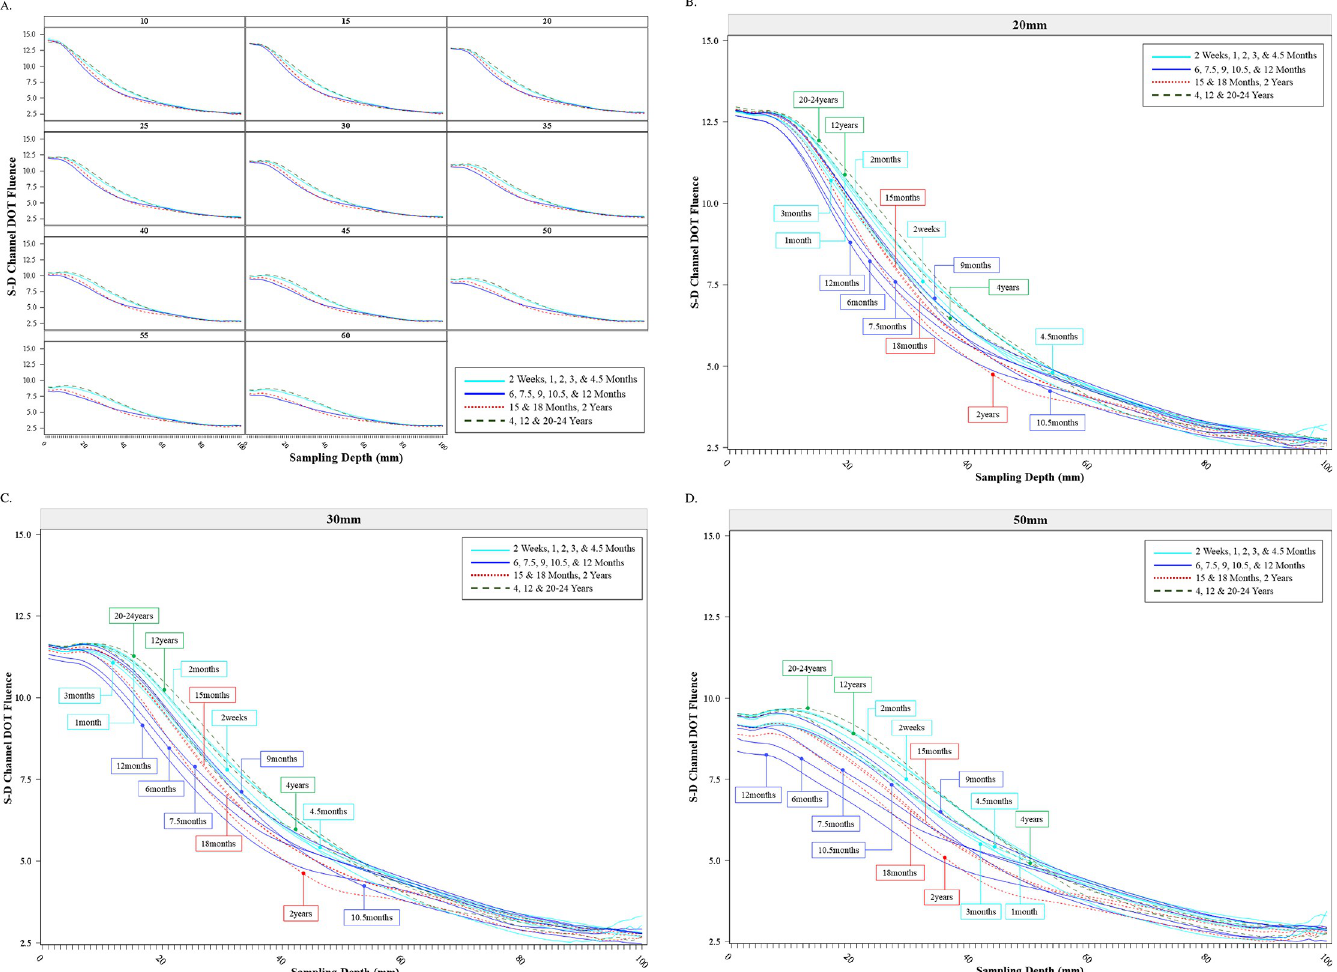
Fig 5. Source-detector (S-D) channel DOT fluence sensitivity profile by age groups. The S-D Channel DOT fluence value was plotted as a function of the sampling depth, defined as the distance (depth) from the channel location to the voxel location in the head model where the S-D channel DOT fluence was measured. A. S-D Channel DOT fluence sensitivity function at each target source-detector separation distances. For visualization, we created four age categories: 2 weeks to 4.5 months, 6 months to 12 months, 15 months to 2 years, and 4 years to 20–24 years. Mean values by each age category are displayed. B. S-D Channel DOT fluence sensitivity function by individual age categories at 20 mm source-detector separation distance. C. S-D Channel DOT fluence sensitivity function by individual age categories at 30 mm separation distance. D. S-D Channel DOT fluence sensitivity function by individual age categories at 50 mm separation distance.